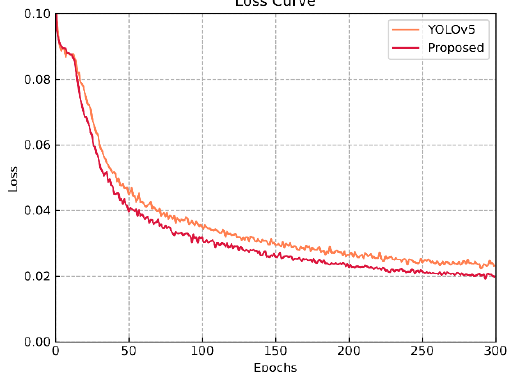
Figure 12. Loss Curve on the HRSC2016 dataset.